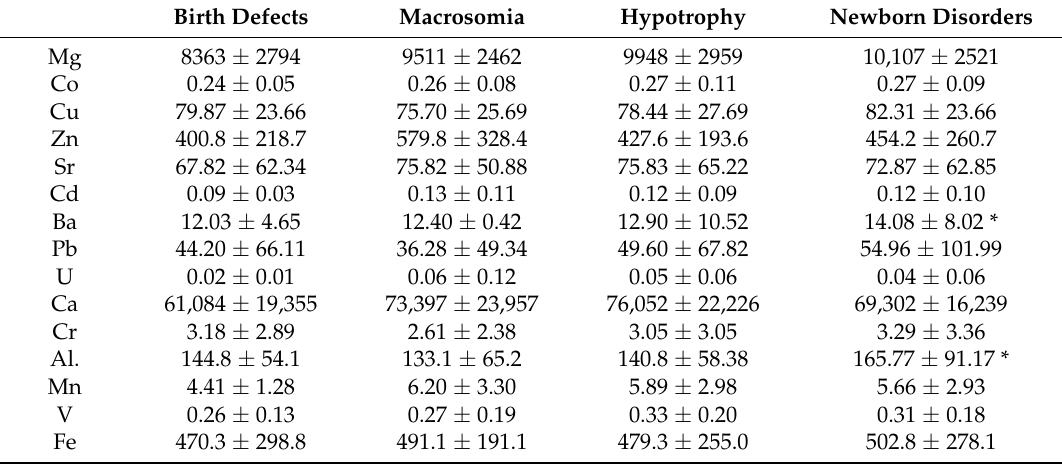
Table 3. Trace elements concentration in amniotic fluid; mean ± SD/median/min-max ( µ g L − 1 ). Birth Defects Macrosomia Hypotrophy Newborn